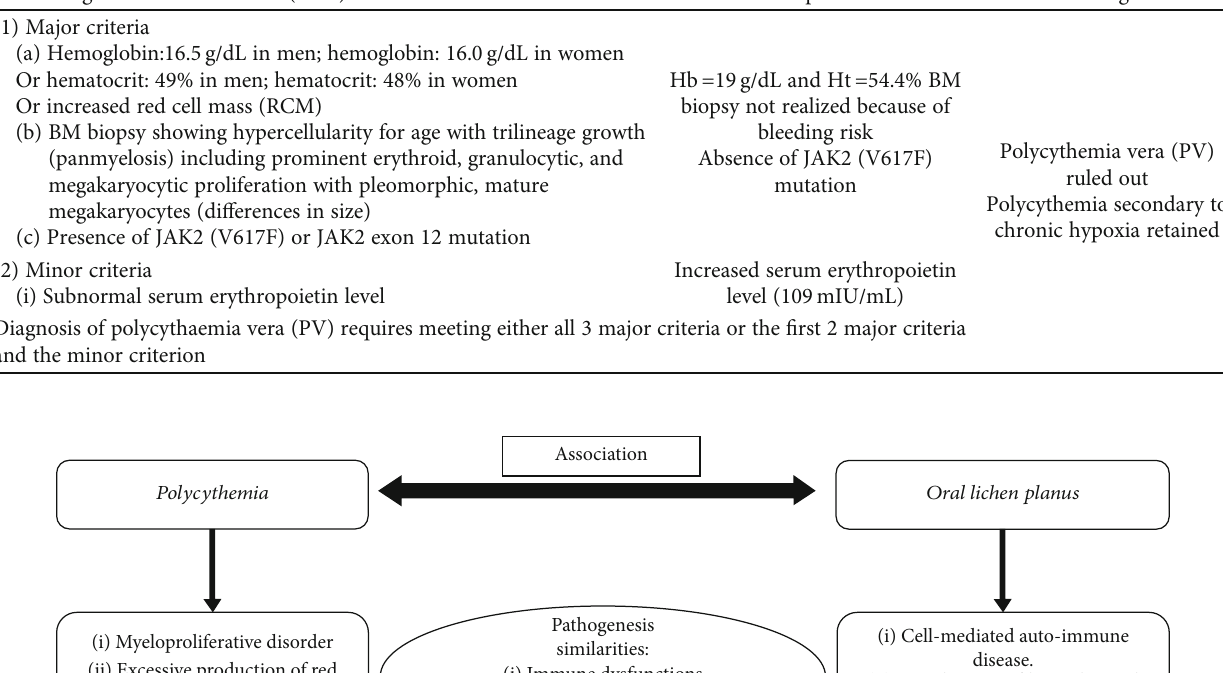
Table 2: The WHO diagnosis criteria for PV (2016) and the diagnosis retained. WHO diagnostic criteria for PV (2016)